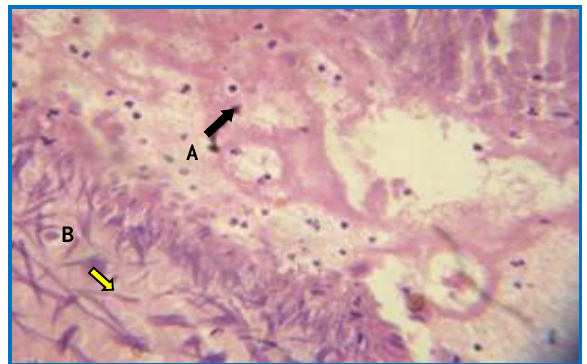
Figure, 5: Group B, three days postoperation there is fibrin network deposition with neutrophils infiltration (A), fragmented muscle fibers (B). (H and E 40X).